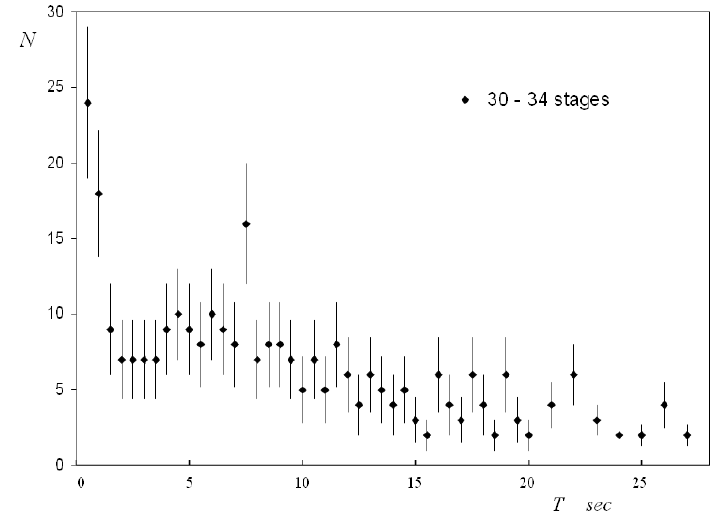
Figure 4. T distribution for fish eggs at 30 ÷ 34